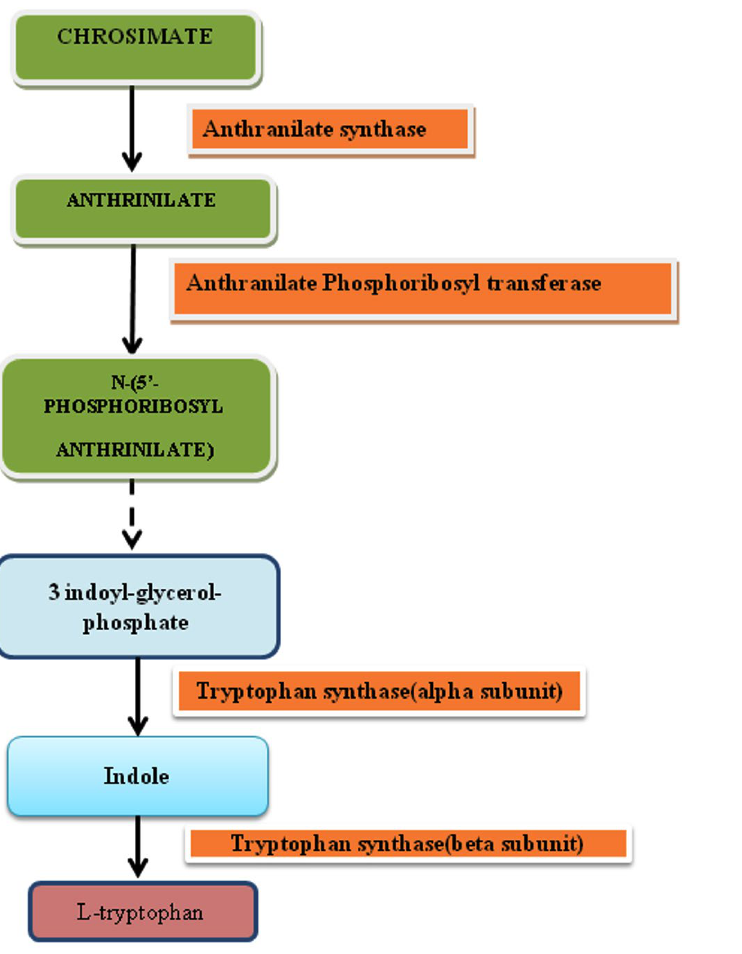
Fig. 1. Biosyntheis of